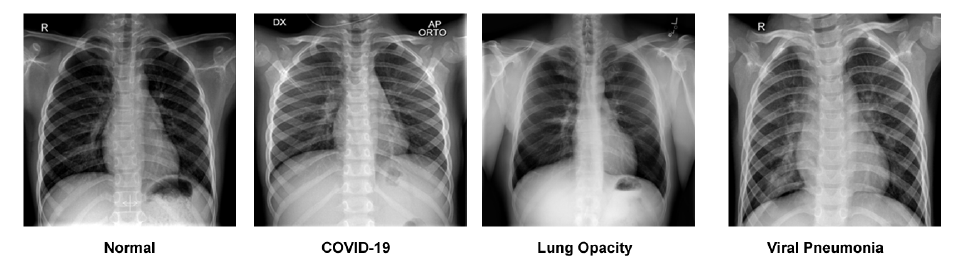
Figure 1. A sample of the COVID-19 Radiography Database.